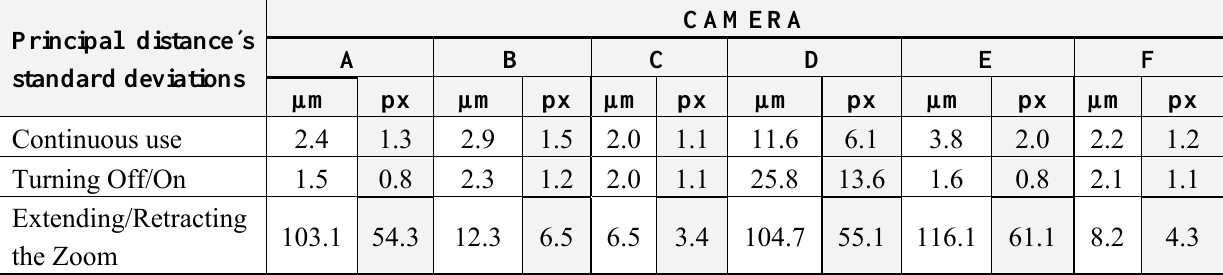
Table 2. Variations of the principal distance, expressed by standard deviations obtained from the six cameras tested in the 20 modeling